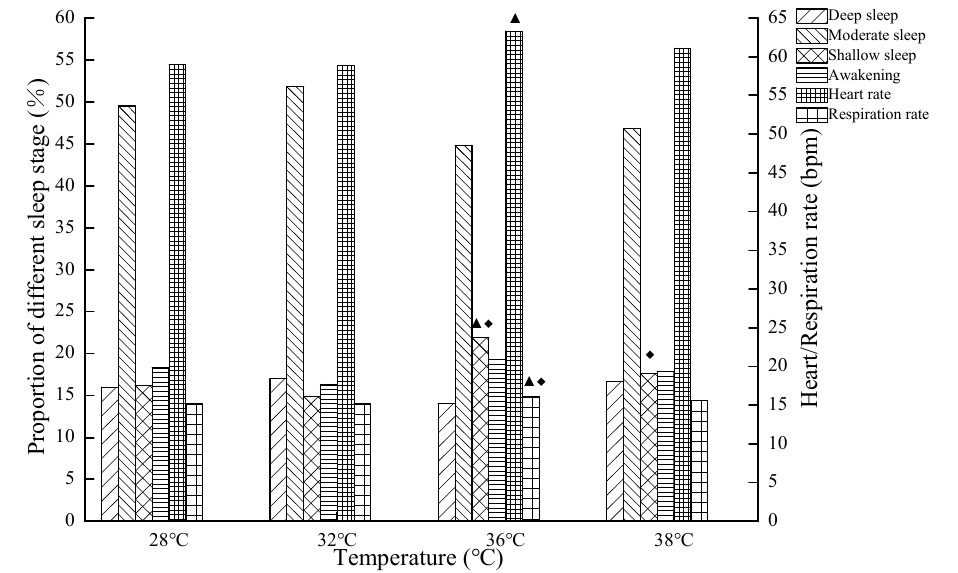
Figure 4. The average heart rate, average respiration rate, and proportion of deep sleep, moderate sleep, shallow sleep, and awakening, at 28 °C, 32 °C, 36 °C, and 38 °C (The legend ▲ indicates that there is a significant difference compared with 28 °C ( p < 0.05), the legend ◆ indicates that there is a significant difference compared with 32 °C ( p < 0.05)).